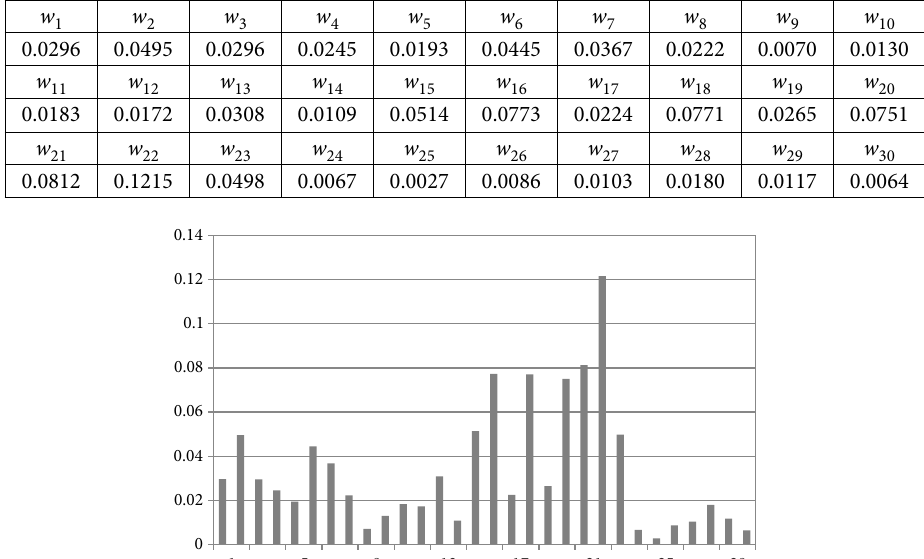
Table 6. Objective criteria weights after the aggregation of individual matrices using the arithmetic mean